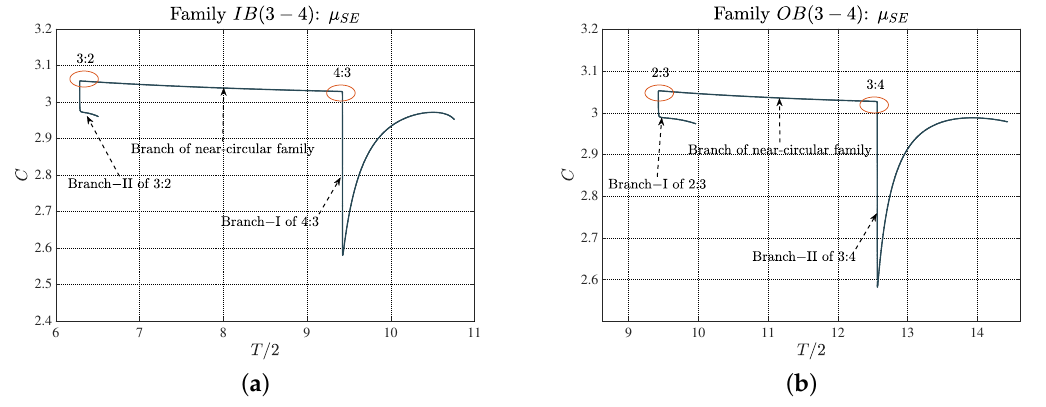
Figure 5. The family IB ( 3 − 4 ) ( a ) and the family OB ( 3 − 4 ) ( b ) in the Sun–Earth system ( µ SE ), shown in the T − C plane. The abscissa is half the orbital period ( T /2) in the synodic frame and the ordinate is the Jacobi constant C